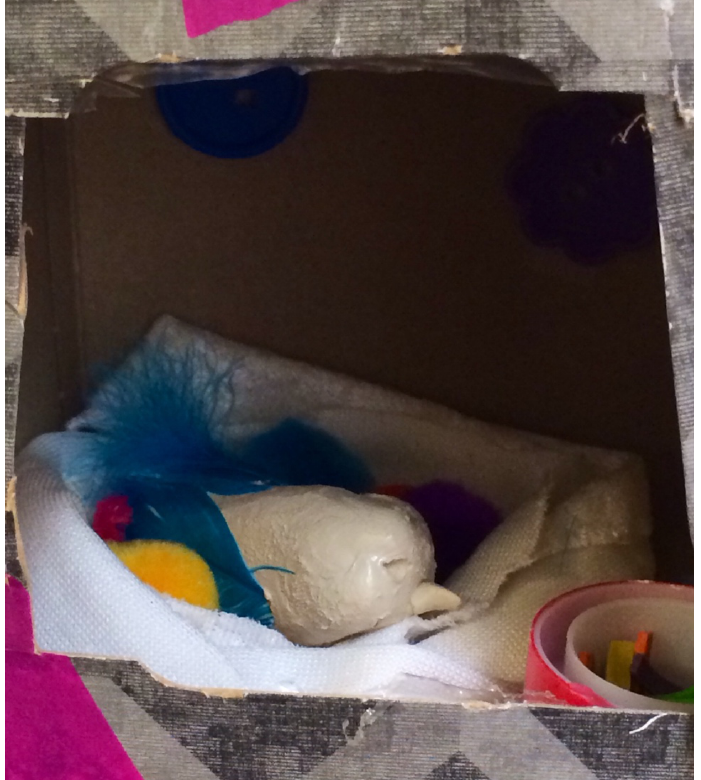
Figure 1 Figure 1. A bird with no name was born. Mixed media (tissue box, clay, feathers, fabric, tape, cut paper, buttons,